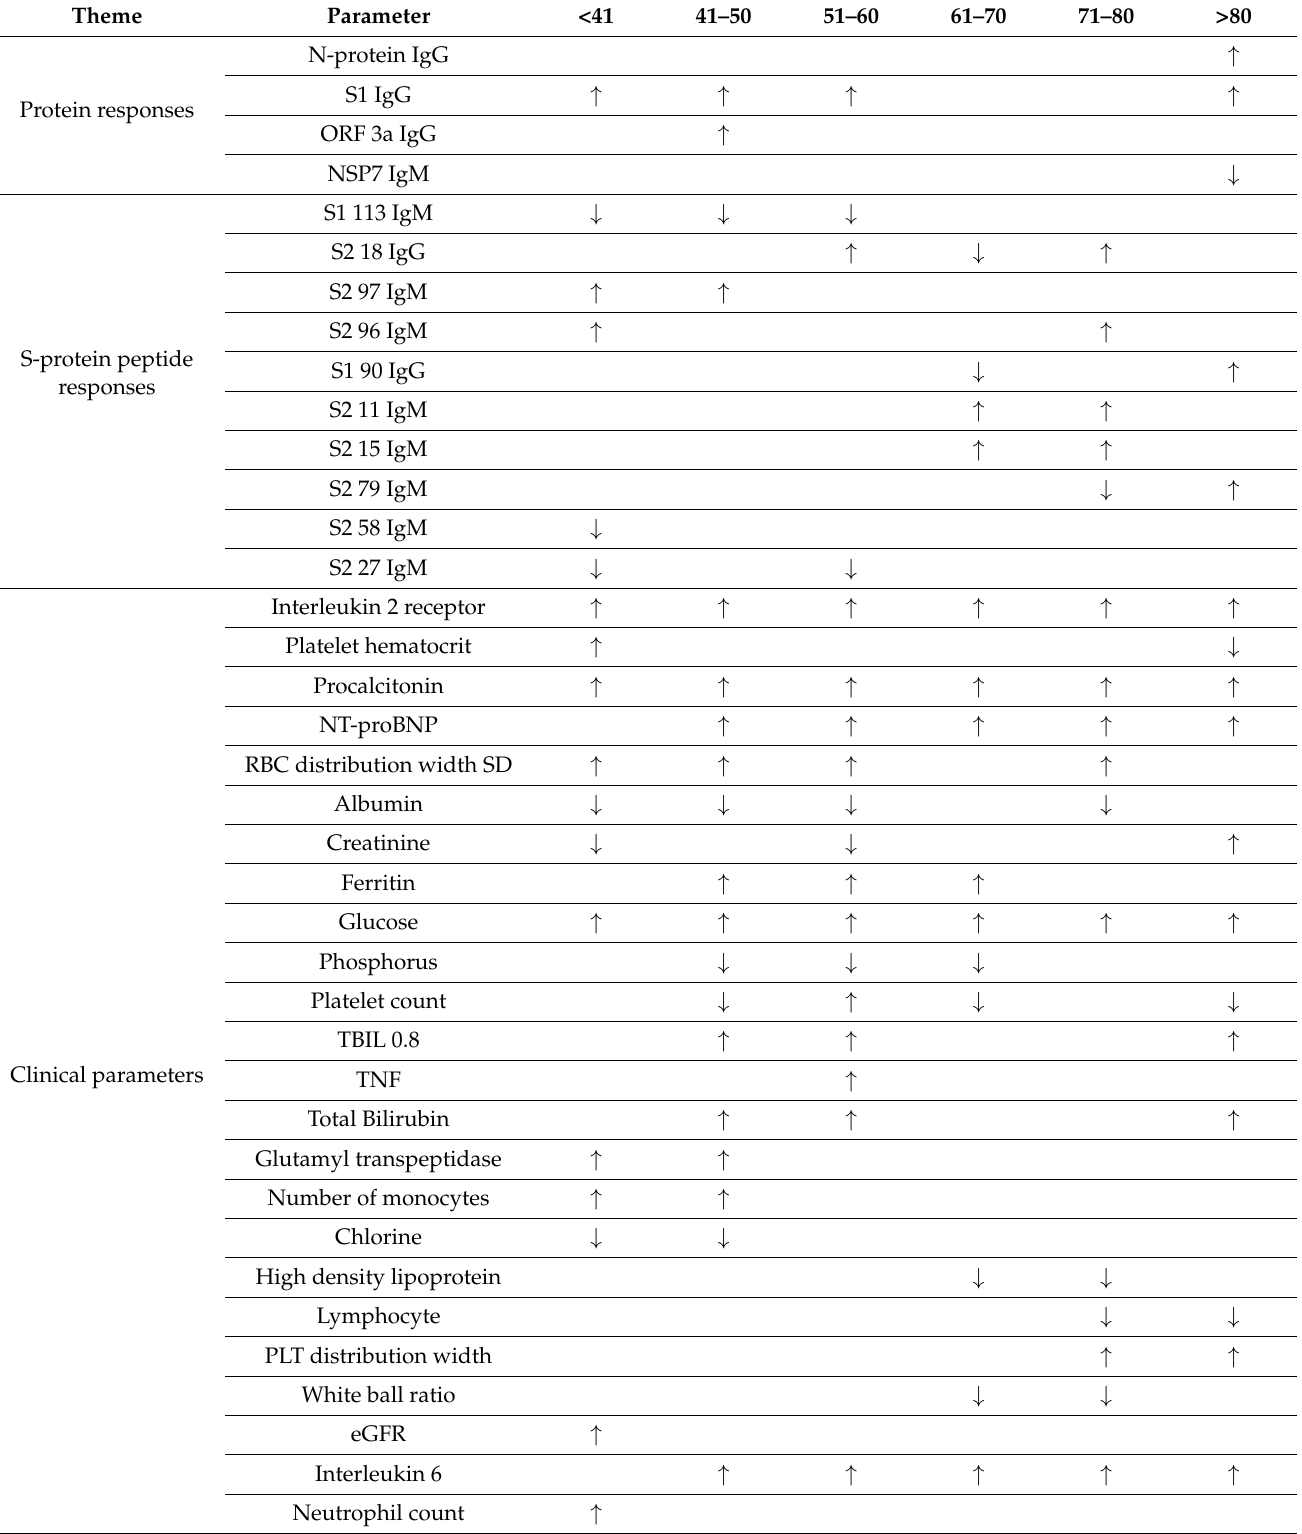
Table 4. The landscape of severity-associated SARS-CoV2-specific antibody responses and clinical parameters in different age